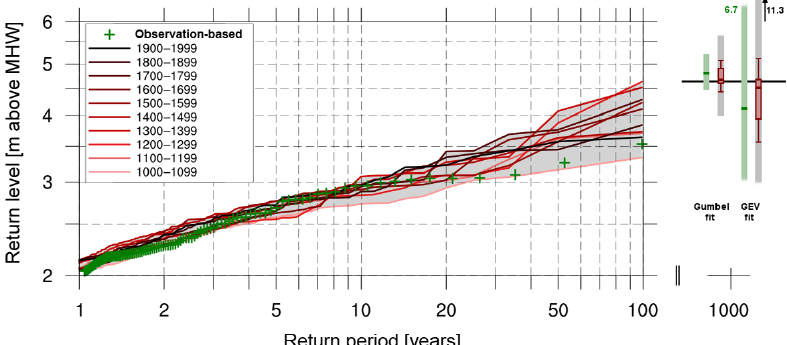
Figure 5. Return value plot using nonparametric plotting positions of simulated sea level at Cuxhaven (colored lines represent 100-year-long subsets of the full 1000 years) against observations from tide gauges (green crosses). The bars on the right mark the corresponding RL 1000 estimates using a Gumbel (left) and GEV (right) fit to the observations (dark green, 95% confidence interval in light green) and to each 100-year subset of the simulation (red box-whiskers, range of the 95% confidence intervals in grey). The horizontal black line shows the RL 1000 directly inferred from the full simulation.